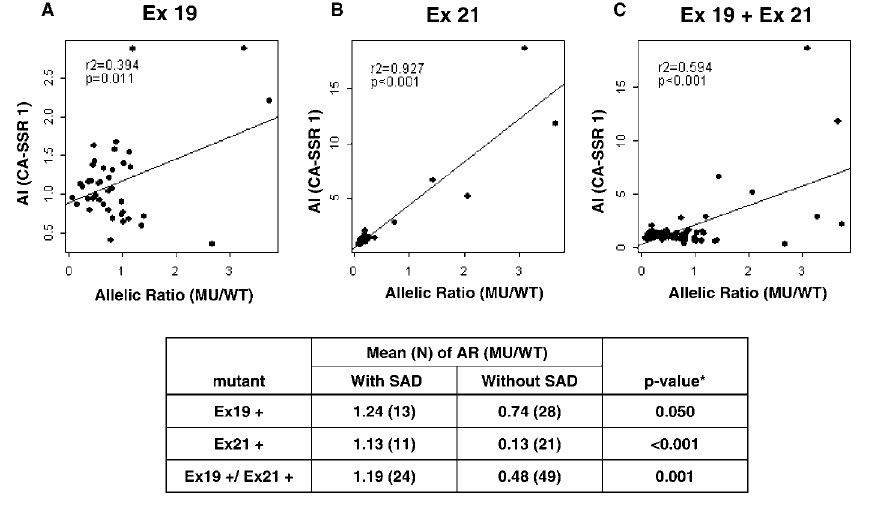
Figure 3. The Correlation between AI and Allelic Ratio The correlation between allelic ratio of CA-SSR1 (shorter allele/longer allele) and the allelic ratio (AR) of mutant (MU) to WT allele of (A) the exon 19 in- frame deletion ( r 2 ¼ 0.394, p ¼ 0.011), (B) the exon 21 L858R point mutation ( r 2 ¼ 0.927, p , 0.001), or (C) both ( r 2 ¼ 0.594, p , 0.001) in the same mutant cases.